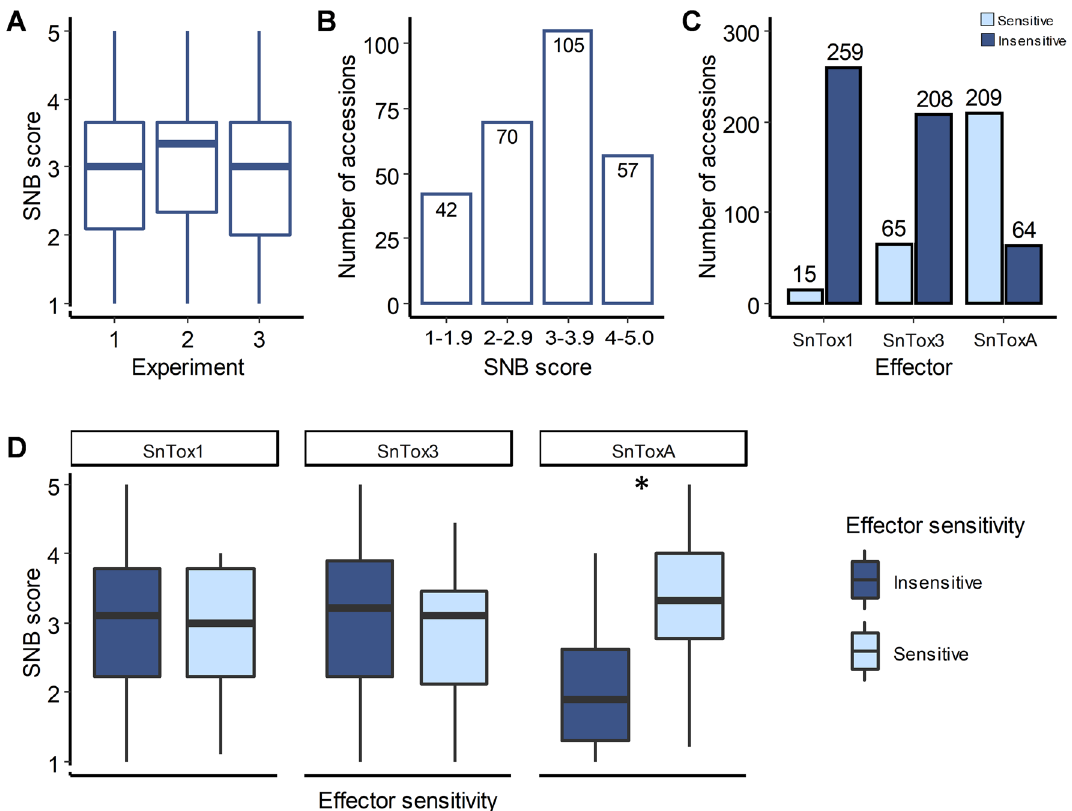
Figure 1. SNB response and necrotrophic-effectors sensitivity reaction of hard winter wheat association mapping panel (HWWAMP) accessions. (A) Boxplots showing the distribution of SNB scores of 274 HWWAMP accessions in the three experiments. (B) Disease distribution of Sn2000 inoculations in 274 accessions. (C) Sensitivity reaction of the 274 accessions against SnToxA , SnTox1, and SnTox3. (D) Boxplots for average SNB scores versus sensitivity reaction for three necrotrophic effectors. T-test was used for comparison between groups for SNB score. Asterisk denotes significant difference ( P < 0.01 ).